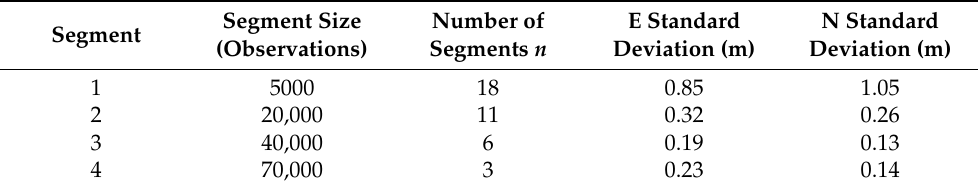
Table 2. Segment type, segment size, number of segment, and associated East, North standard deviations, from Equation (1) with the n values: 18, 11, 6, and 3. Segment Size Segment (Observations) Segments